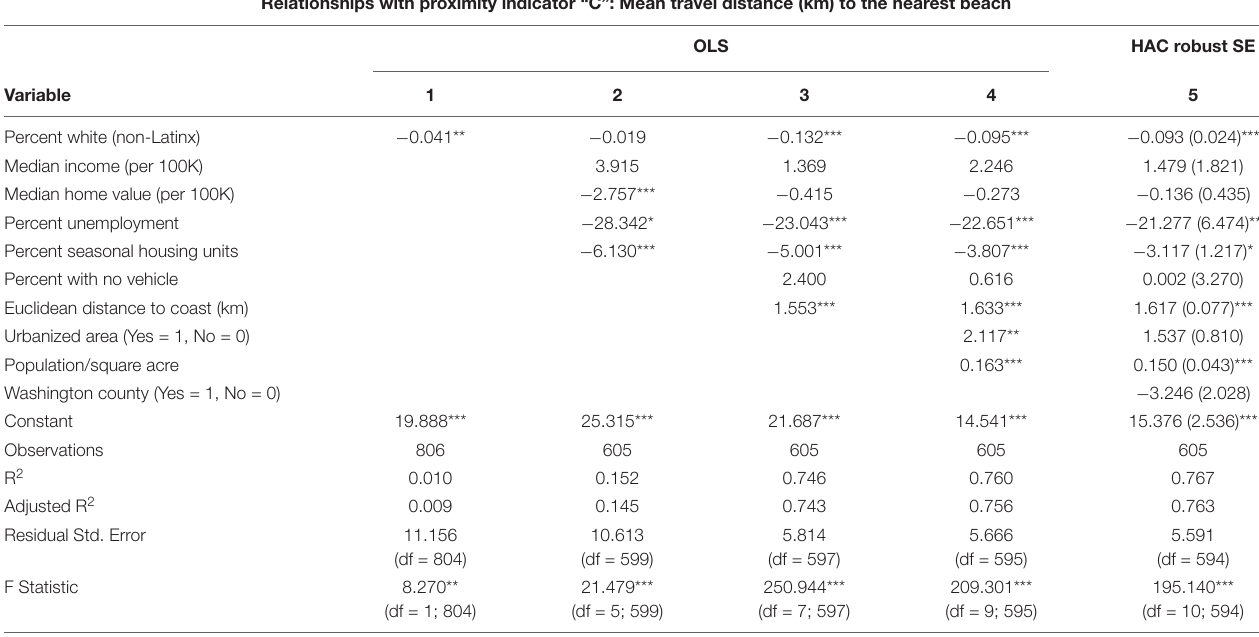
TABLE 3 | Set of regressions showing relationships of controls with proximity indicator C, mean travel distance to nearest public beach (km). Relationships with proximity indicator “C”: Mean travel distance (km) to the nearest beach